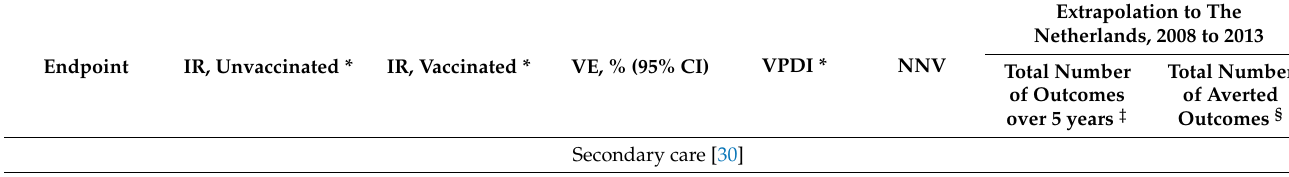
Table 1. Incidence rates and vaccine-preventable disease incidence rate (VPDI) per 100,000 person- years of observation and numbers needed to vaccinate (NNV) based on 5 years of 13-valent pneumo- coccal conjugate vaccine (PCV13) duration of protection against